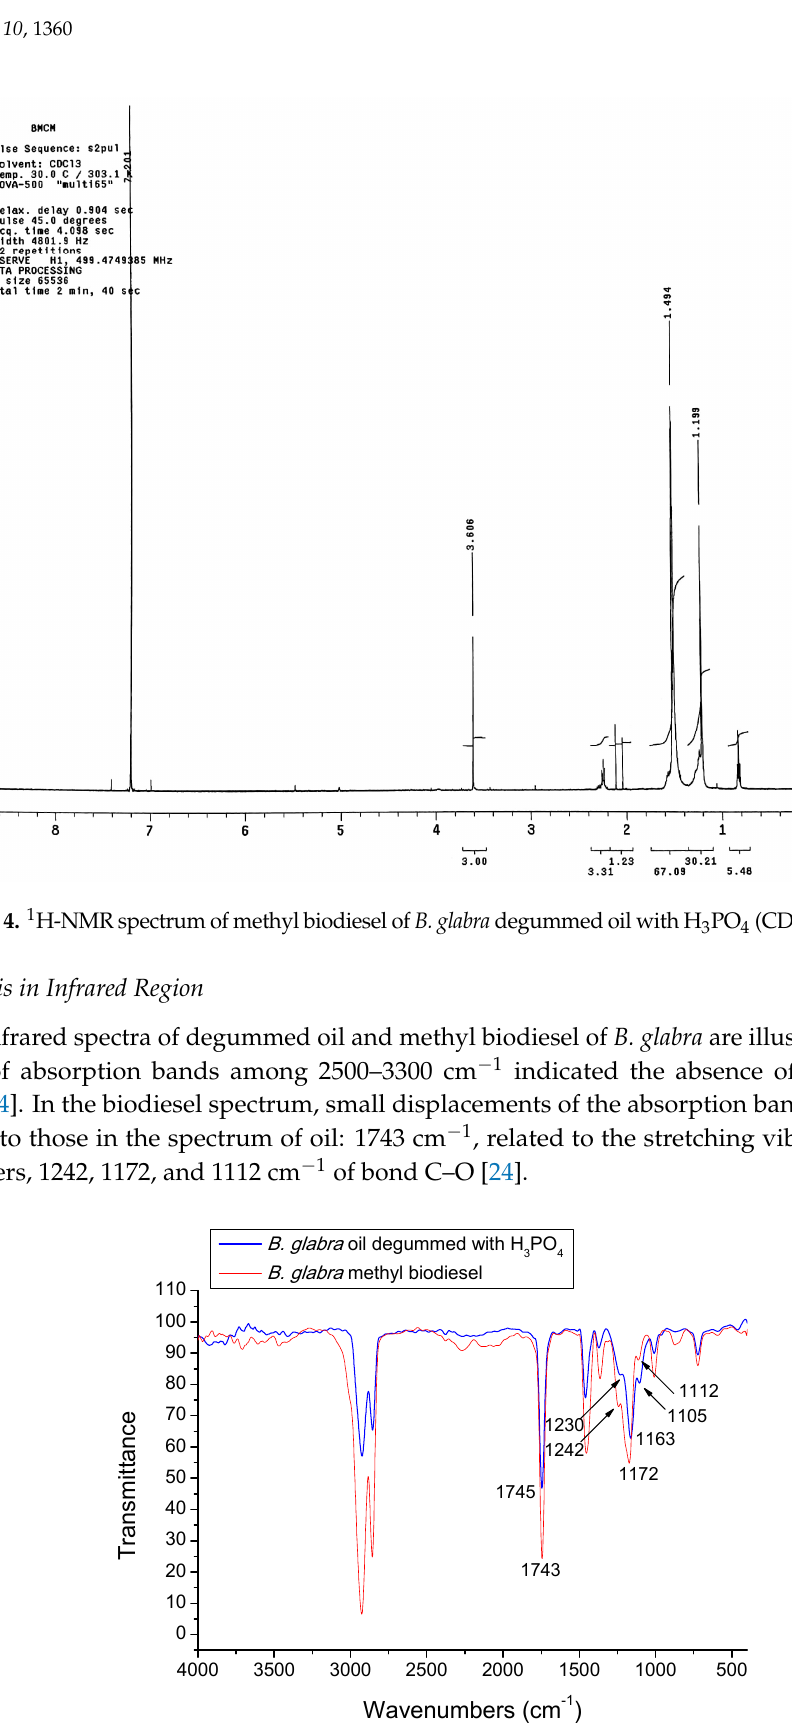
Figure 5. Infrared spectra of degummed vegetable oil and methyl biodiesel of B. glabra.